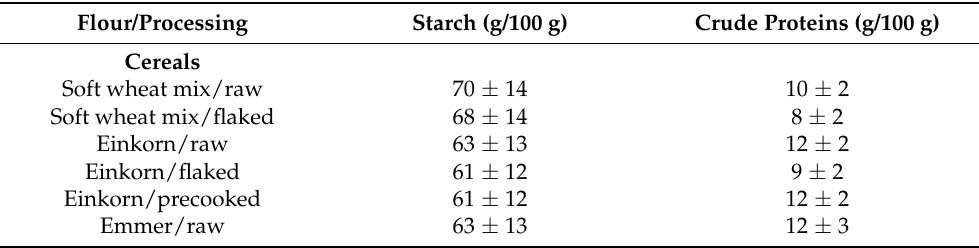
Table 2. Starch and crude proteins contents in the flours, reported as mean ± SD ( n = 9) and expressed as g/100